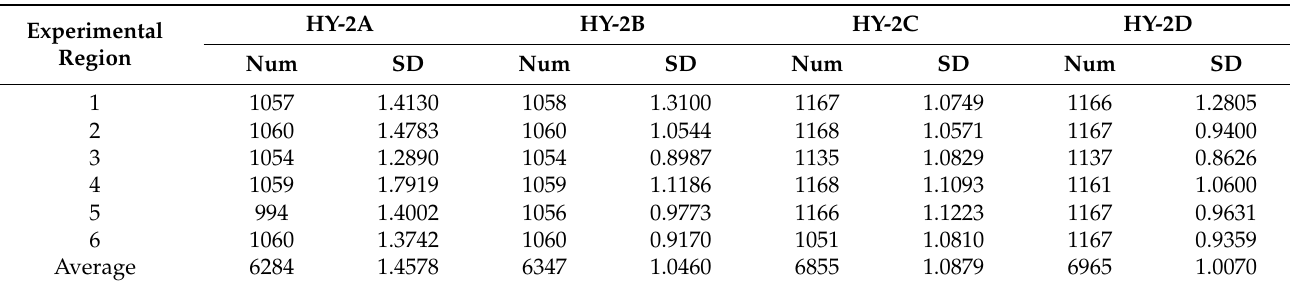
Table 7. Comparison of determined along-track vertical deflections with XGM2019 for HY-2 missions (unit: arcsec): Region 1, North Pacific; Region 2, South Pacific; Region 3, Mid-Pacific; Region 4, Indian Ocean; Region 5, North Atlantic; Region 6, South